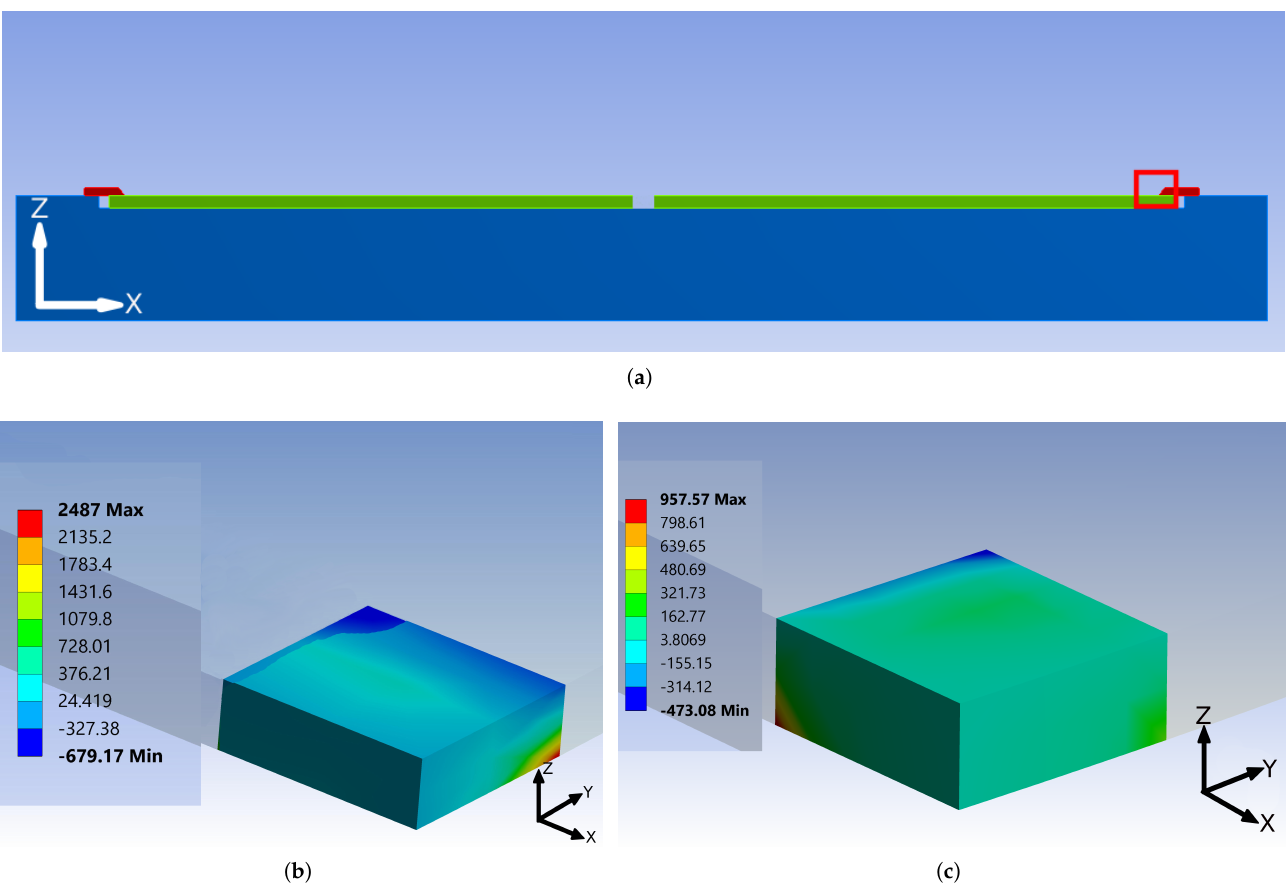
Figure 5. Out-of-plane deflection vs. the diameter of central hole.